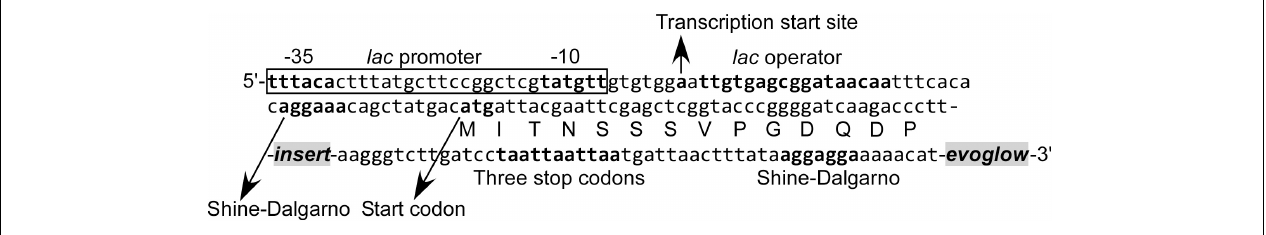
FIGURE 1 | Nucleotide and amino acid sequence in the vicinity of DNA fragment inserted into the pK18evoglow-TOPO vector.